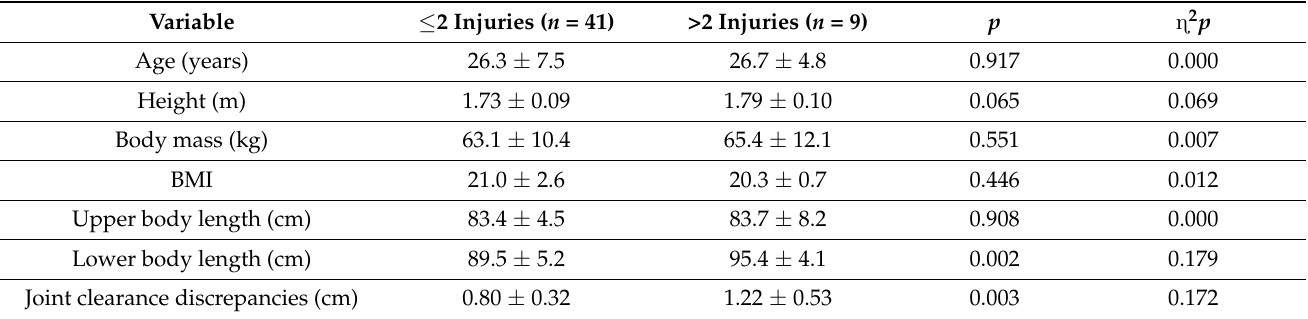
Figure 2. Pearson’s correlation (±95% confidence intervals) between joint clearance discrepancy (JCD) and number of injuries ( left ) and injury severity ( right ). Table 5. Age and anthropometric outcomes in athletes ≤ 2 injuries and athletes with > 2 injuries.